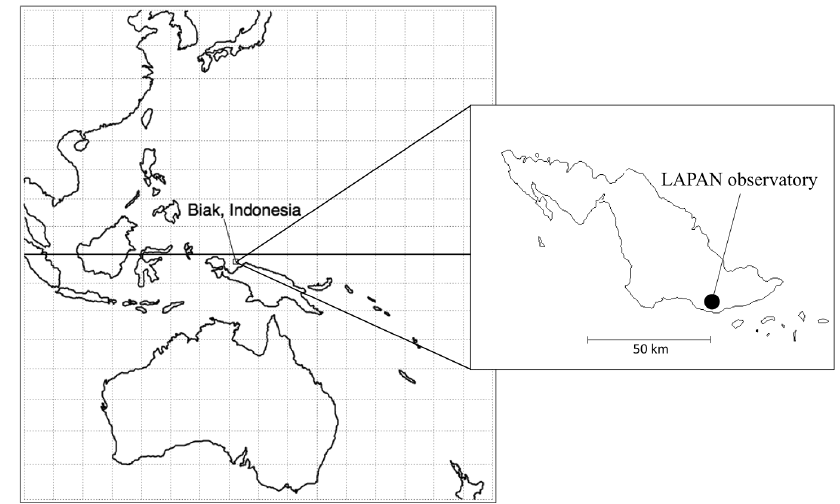
Figure 1. Map showing Biak, Indonesia and the LAPAN observatory on the island.